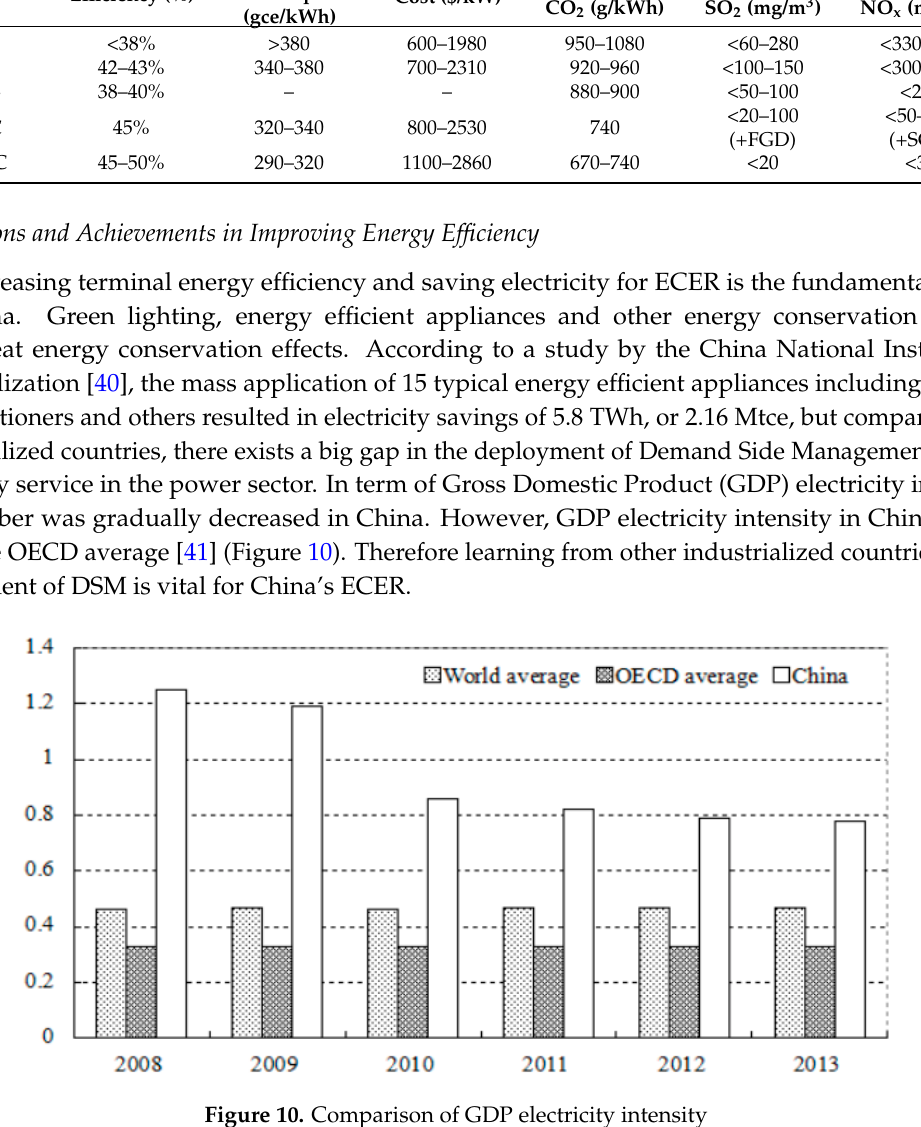
Table 3. Installed capacity in related plans and the baseline power planning scenario in China in 2020 (GW).